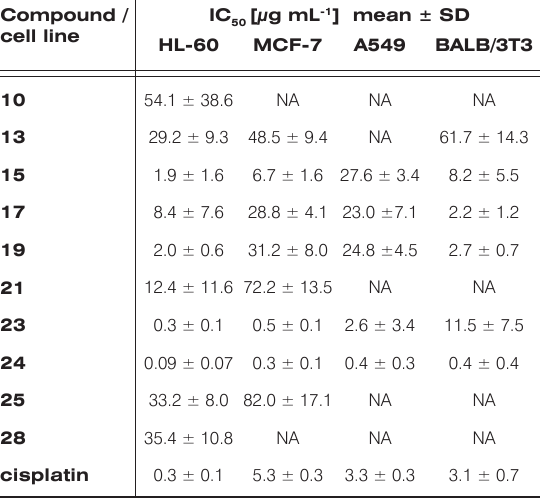
Table 2. The antiproliferative activity of selected compounds. Compound / cell